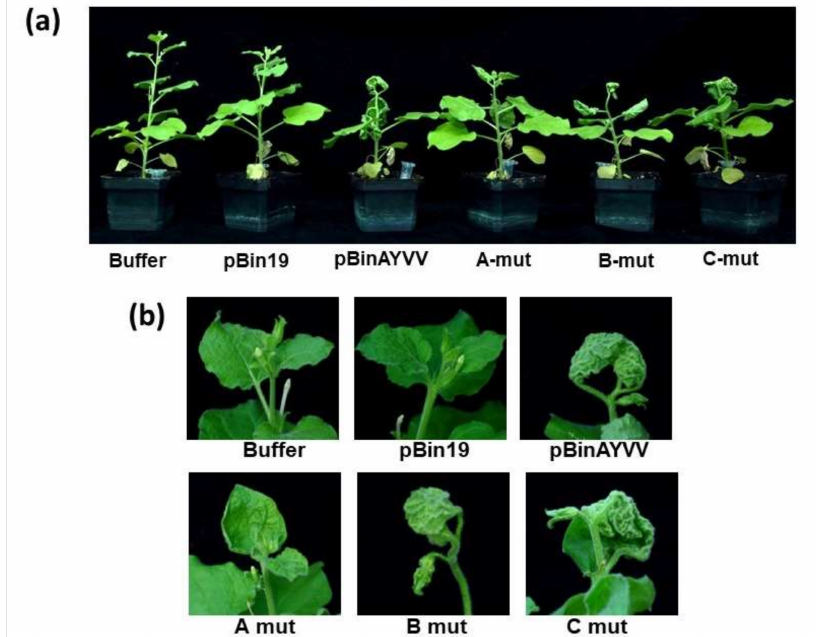
Figure 5. Inoculation assay of AYVV-NT mutants on N. benthamiana . A. tumefaciens cells (OD 600 = 1.2) harboring various infectious constructs of AYVV-NT mutants as indicated at the bottom were in- oculated into N. benthamiana . ( a ) Side view of the whole plants infiltrated with different construct. ( b ) Close-up view of the young leaves of the infiltrated plants. The symptoms were recorded at 24